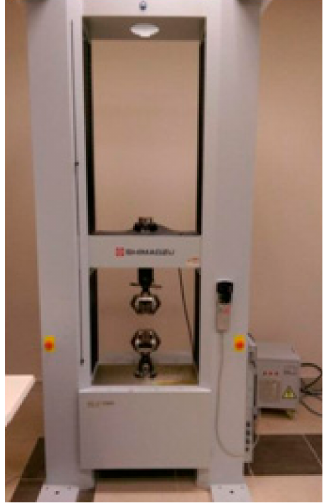
Figure 2. Shimadzu ag-x 10-ton Draw